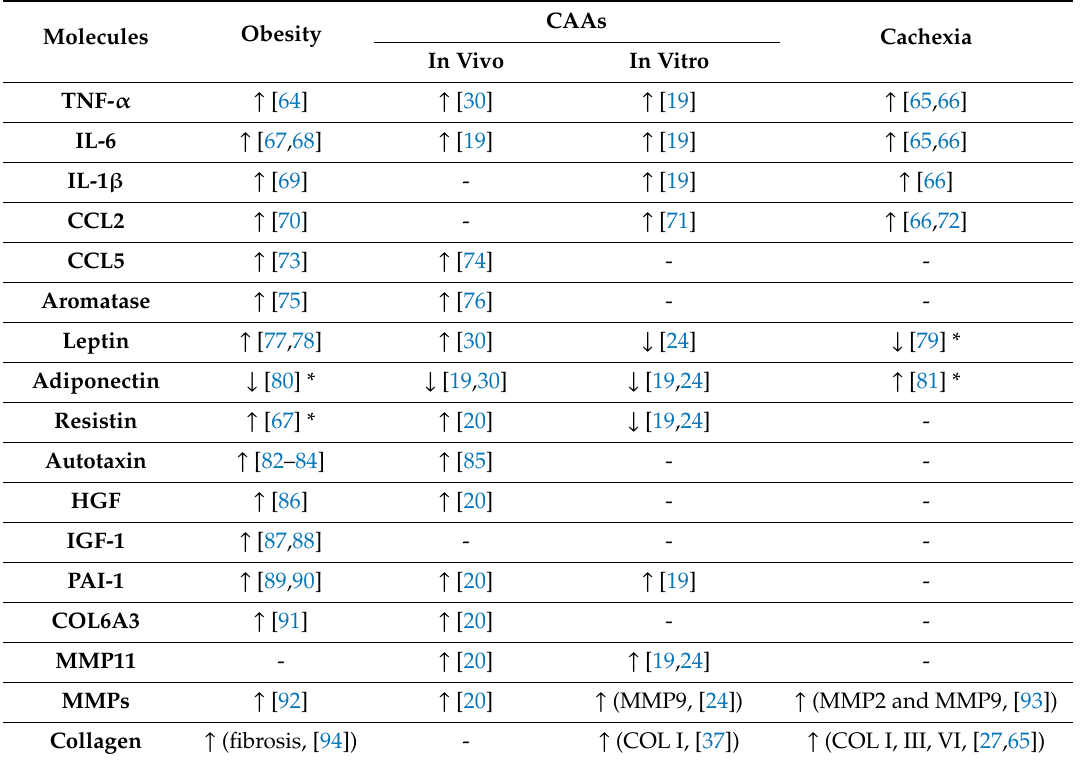
Table 3. Molecules at the basis of the pro-tumorigenic e ff ect of adipocytes in obesity, cachexia, and after interaction with